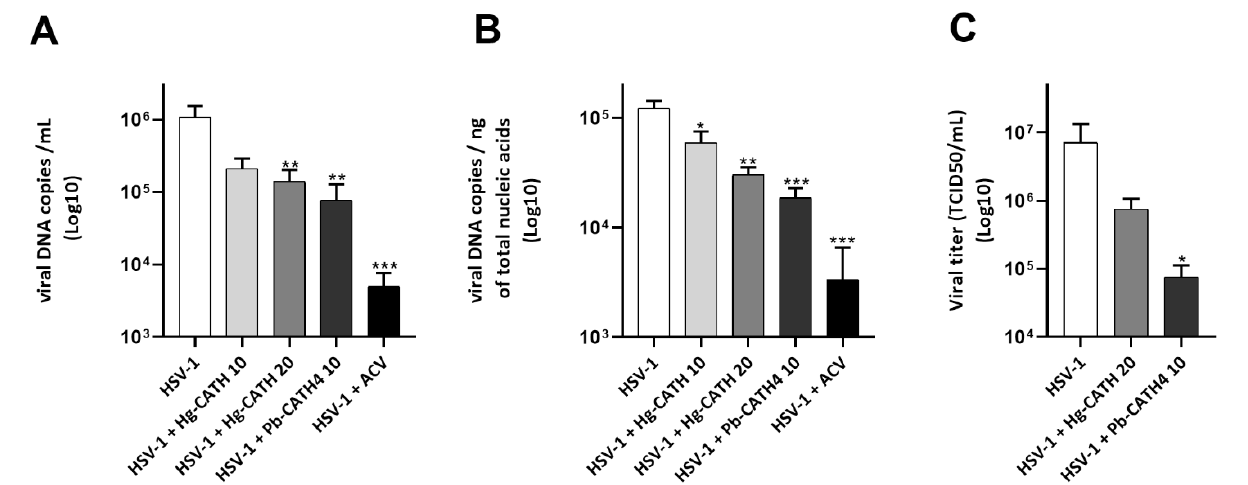
Figure 3. Evaluation of Hg-CATH and Pb-CATH4 antiviral activities during primary human keratinocyte infection with HSV-1. Primary human keratinocytes were treated with 10 or 20 µ g/mL of Hg-CATH, 10 µ g/mL of Pb-CATH4, or 10 µ g/mL of ACV before being infected 24 h with HSV-1 at a multiplicity of infection (MOI) of 0.1. Viral DNA quantification was determined in cell supernatant (( A ), log10 viral DNA copies/mL) and in cell monolayer (( B ), log 10 viral DNA copies/ng of total nucleic acids) from infected keratinocytes. Viral titre in cell culture supernatant was determined by end-point dilution assay and expressed in TCID50/mL ( C ). Data are represented as mean + standard error of mean (SEM) of five independent experiments. * p < 0.05, ** p < 0.01, *** p < 0.001 compared with the infected control without AMPs.